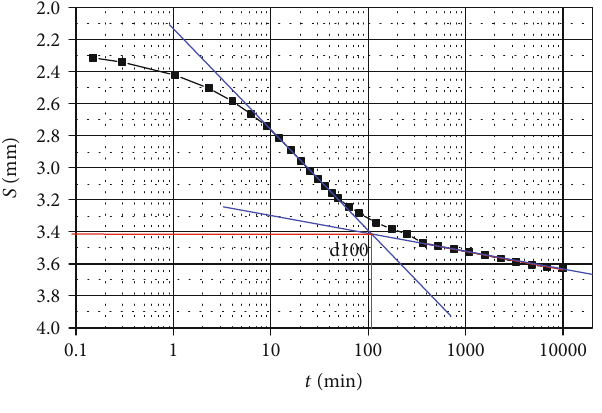
Figure 8: s − lg t